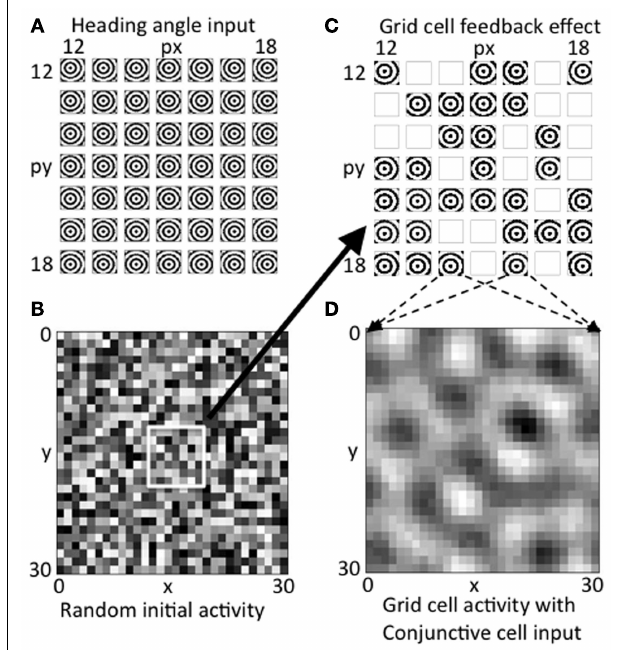
FIGURE 4 |Activity on first two time steps. (A) The array of concentric circles due to summation of synaptic input from all heading angle cells at a 7 by 7 array of heading angle spatial phases.The centers fall at different locations dependent on the different spatial phases of the heading angle cells. (B) Initial random activity in the grid cell population shown for all 30 by 30 spatial phases of grid cells. (C) Feedback from the random grid cell activity in (B) interacts with the corresponding array of heading angle cells at the same spatial phases.Where there is high activity in the grid cell initial random activity, the summation of synaptic input from heading angle planes yields a strong concentric circle input.Where random activity in the grid cells falls below threshold the synaptic input from heading angle cells is absent. (D) The heading angle synaptic input in (C) regulated by random feedback is summed together across the grid cell plane to generate a pattern of activity that already shows peaks of activity falling in a hexagonal pattern due to the overlap of concentric